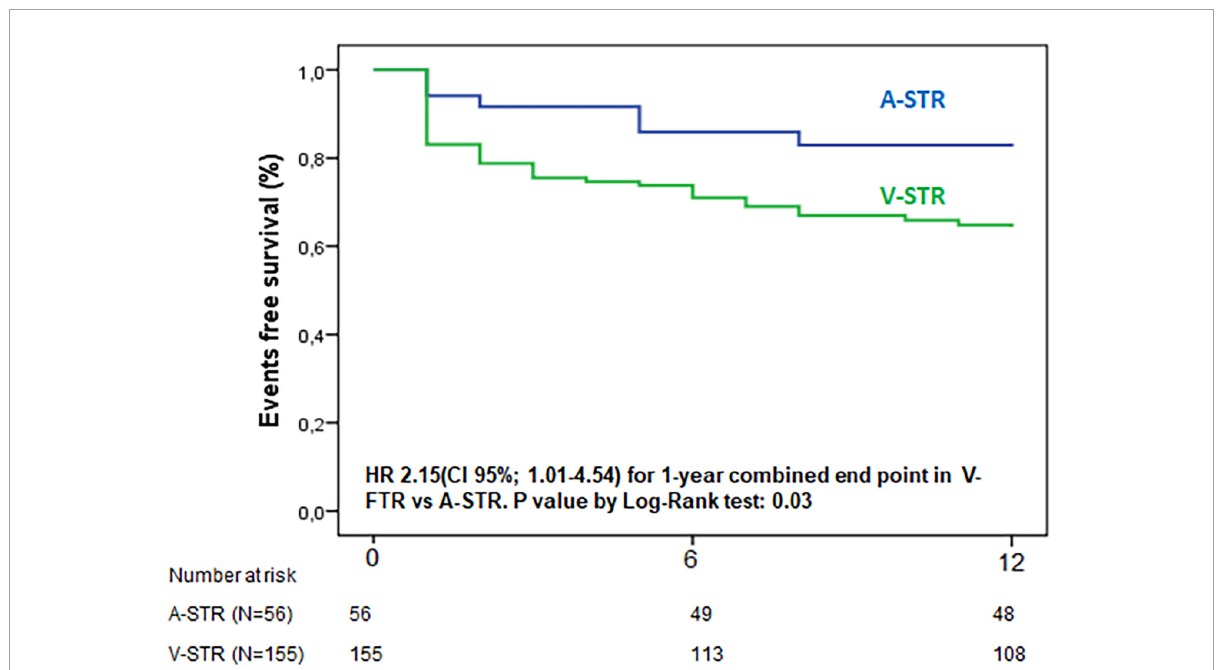
FIGURE3 Kaplan-Meier curves for 1 year combined endpoint of all-cause death and hospitalization for heart failure. A-STR, atrial-secondary tricuspid regurgitation; HR, hazard Ratio; V-STR, ventricular secondary tricuspid regurgitation.